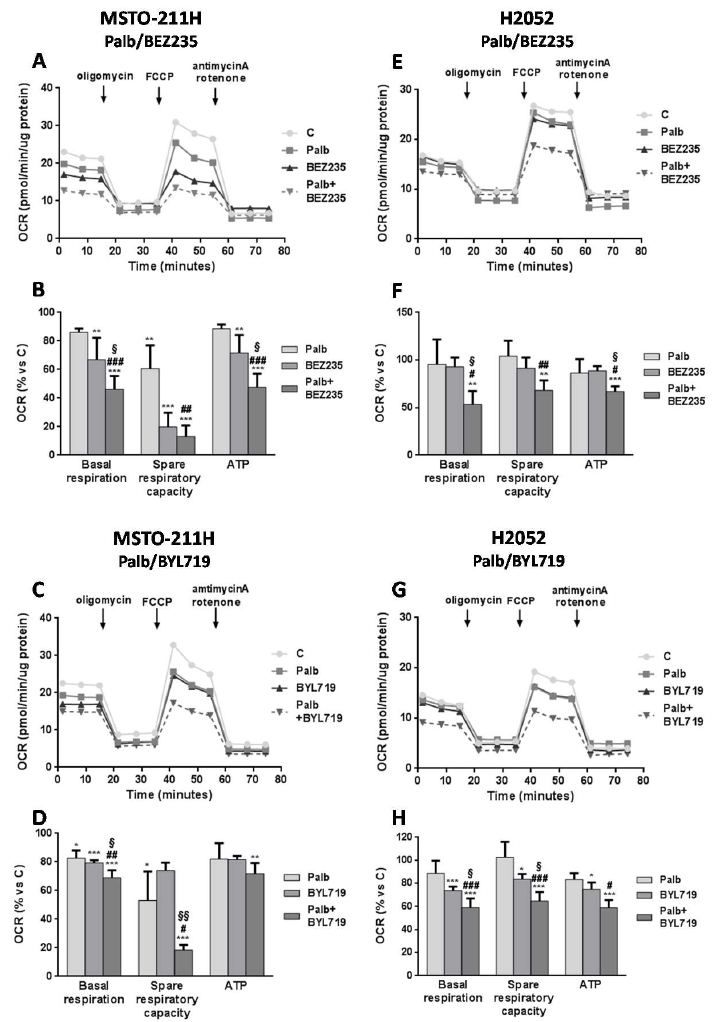
Figure 6. The combined treatment of palbociclib with PI3K / mTOR inhibitors impairs mitochondrial respiration in MSTO-211H and H2052 MPM cells. ( A , C , E , G ) Mitochondrial respiration profiles